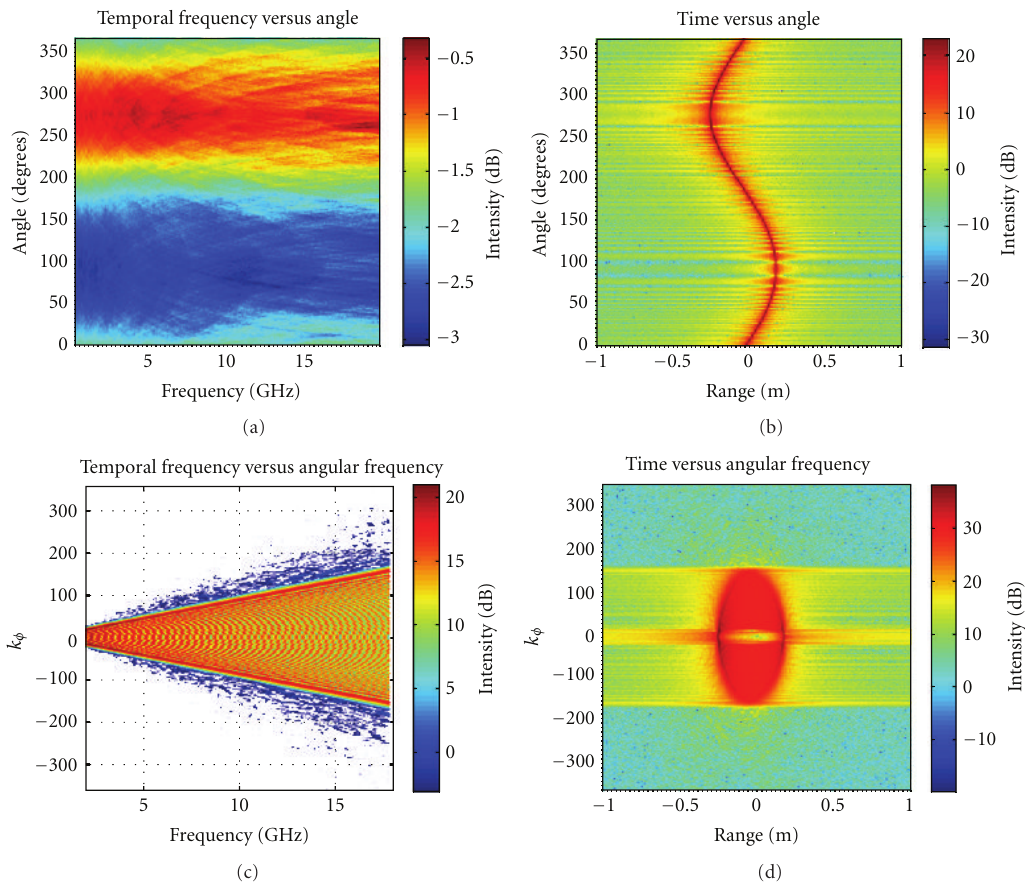
Figure 21: Four representations of the false-target-generated focussing template revolution data for a single antenna pair (BS 6 ): (a) the “raw-data” domain, (b) the “time” domain, (c) the “Fourier” domain, and (d) shown for completeness but not otherwise